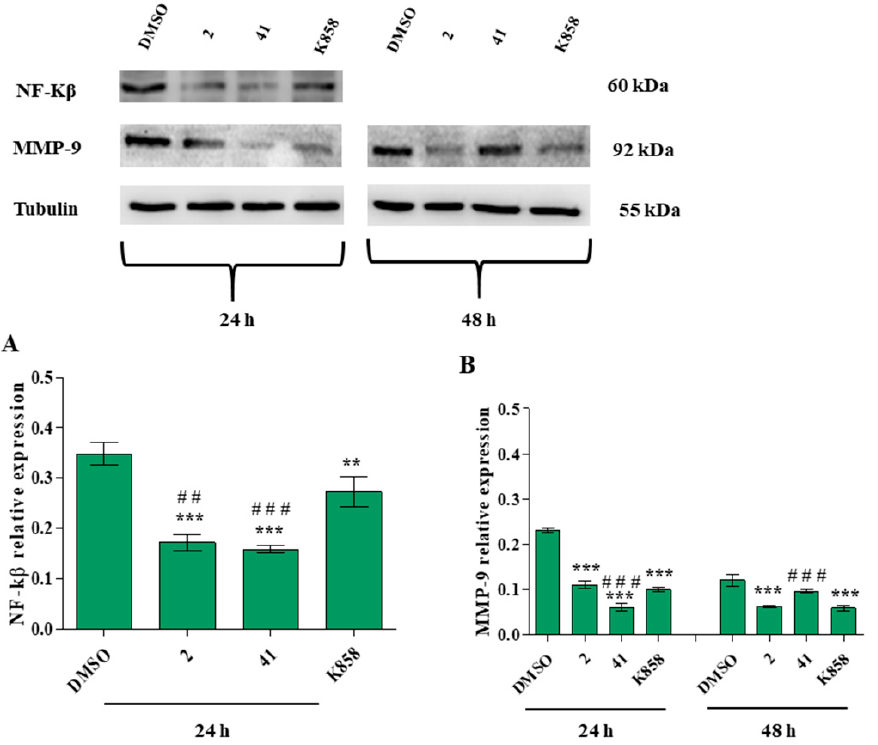
Figure 9. Nuclear factor kappa-B (NF-kB) ( A ) and matrix metalloproteinase-9 (MMP-9) ( B ) protein expression levels in MCF7 cell line treated with 2 (1.5 µ M), 41 (5 µ M) and K858 (10 µ M) for 24 h (for NF-kB) and for 24, 48 h (for MMP-9). DMSO: control vehicle. Data are reported as means ± SD of three independent experiments. Tubulin is used as a loading control. The bar graph displays densitometric values normalized on loading control. *** p < 0.0001 DMSO vs. Eg5 inhibitors; ** p < 0.001 DMSO vs. Eg5 inhibitors; ### p < 0.0001 K858 vs. 2 and 41; ## p < 0.001 K858 vs. 2 and 41.